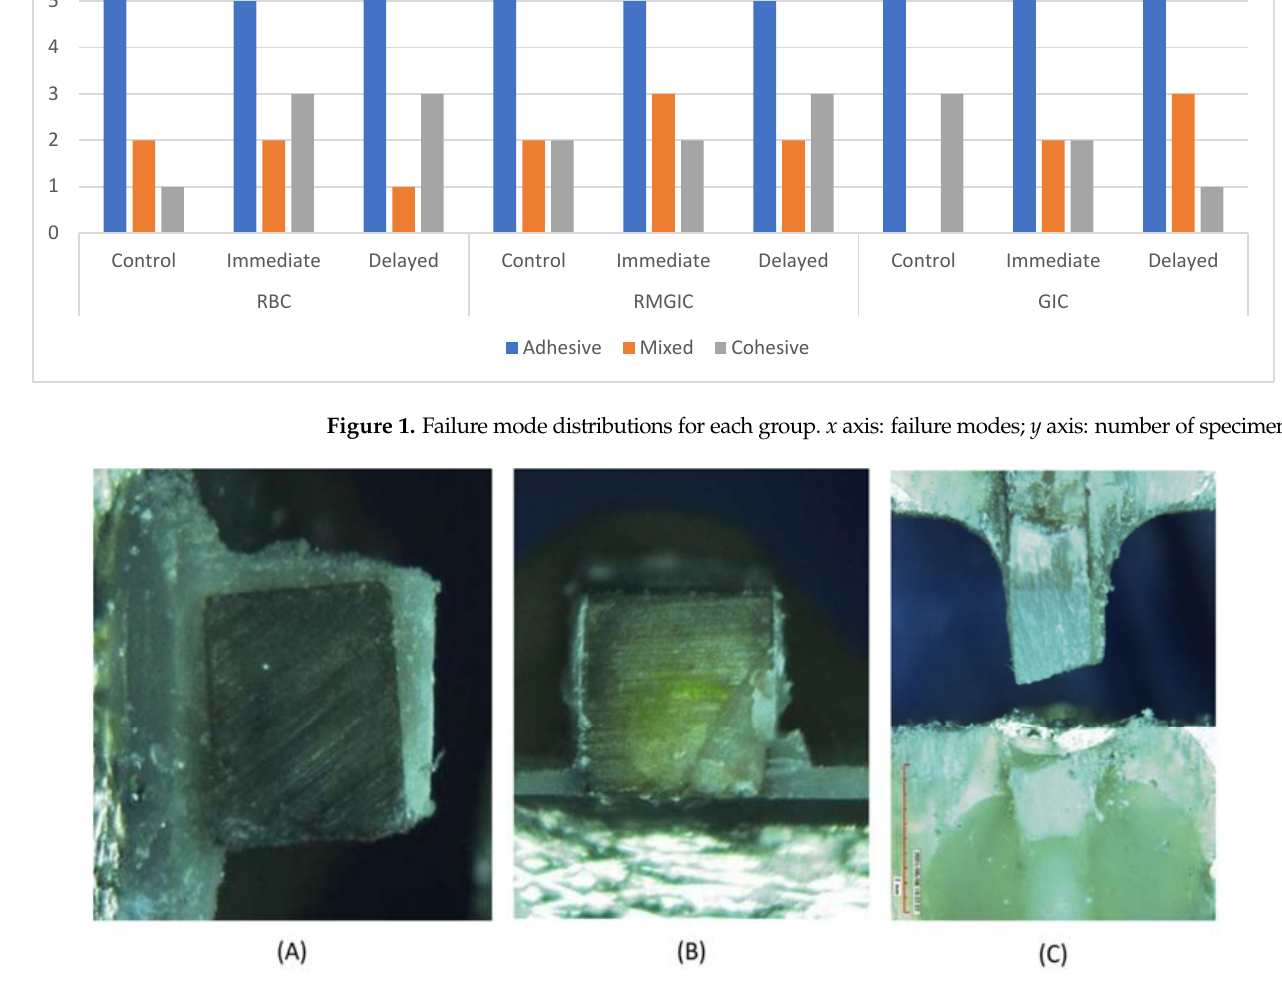
Figure 2. Failure modes of the specimens: adhesive failure ( A ), mixed failure ( B ) and cohesive failure ( C ).